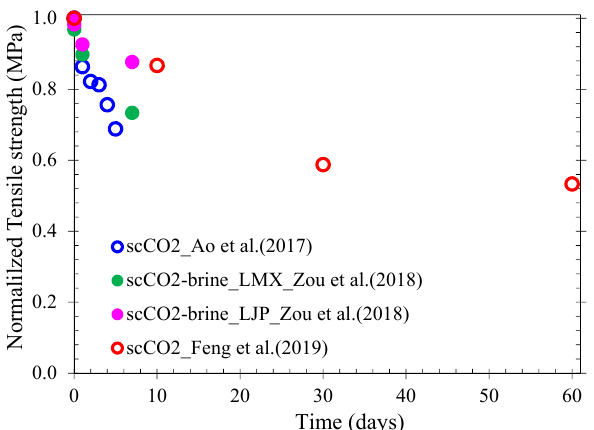
Figure 6. Variation in the normalized tensile strength with exposure time to scCO 2 . In addition to the nomenclature information of Figure 5, LJP and LMX refer to different basins, as indicated in Table 1.